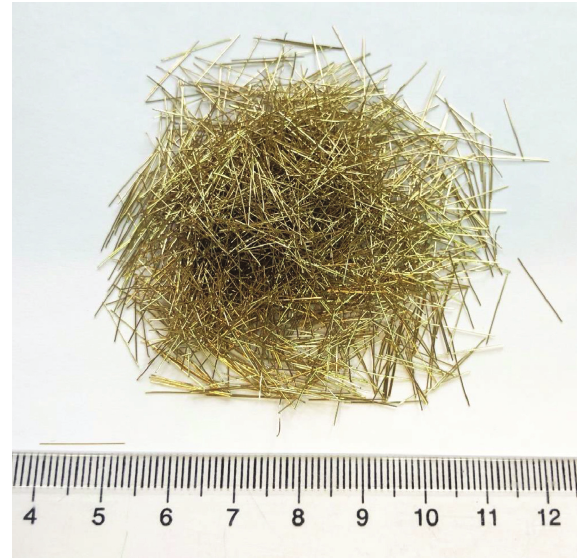
Figure 2: Steel fibers.